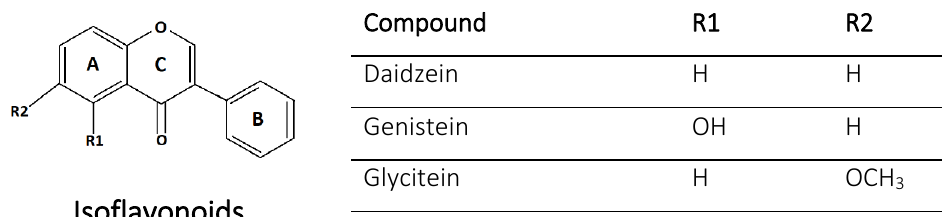
Figure 5. Isoflavonoids: chemical structure, types and substitution positions in the basic skeleton.